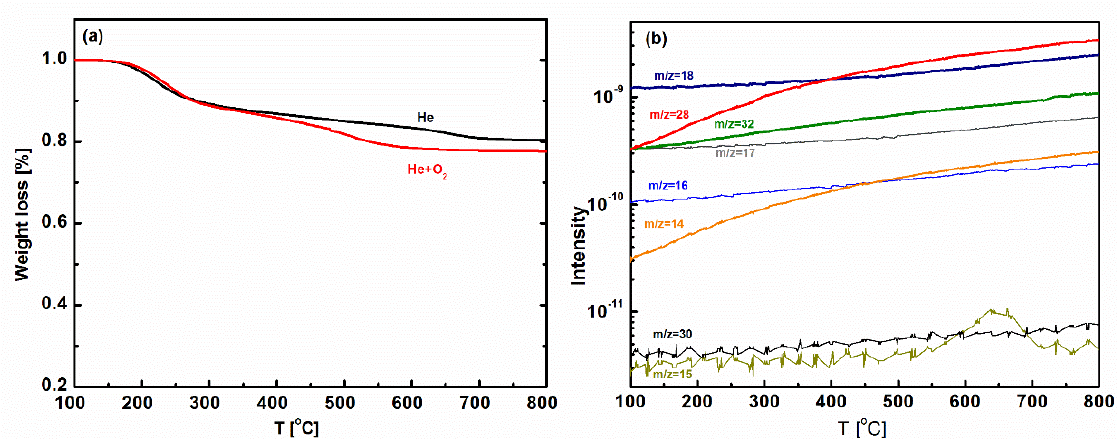
Figure 3. ( a ) Thermogravimetric (TG) curves of BTESE-PNEN powders under He and He+O 2 atmospheres; ( b ) mass signals of BTESE-PNEN under He atmosphere.